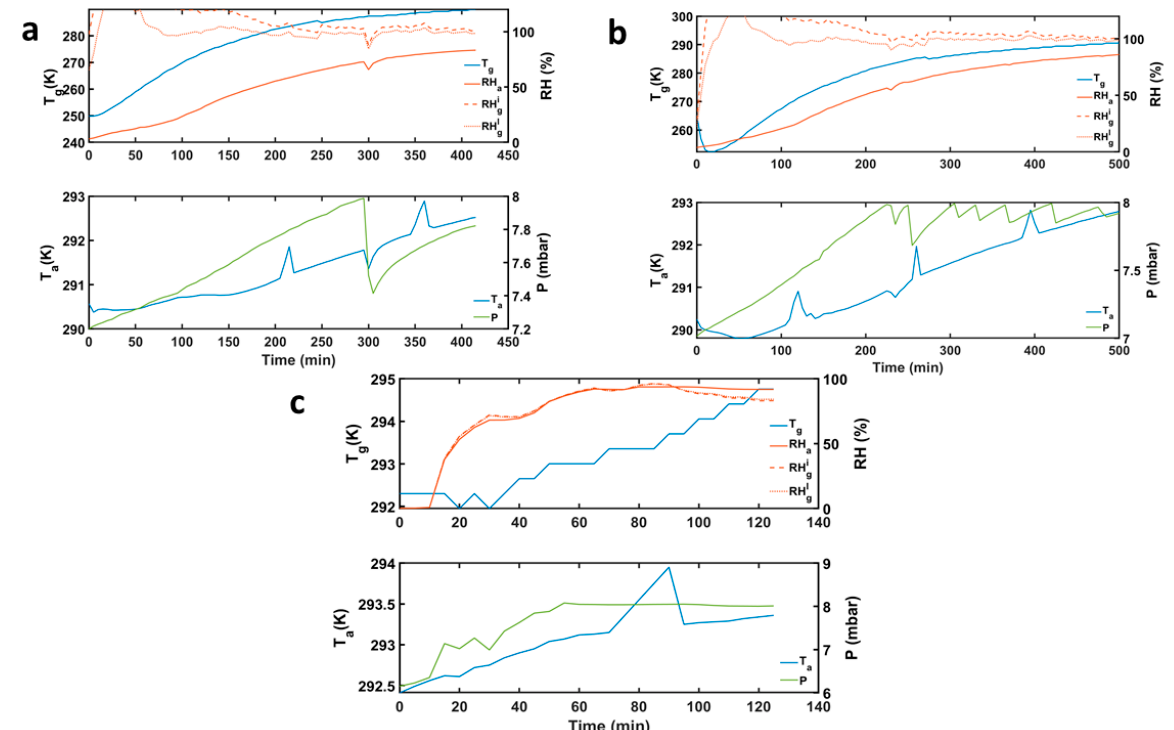
Figure 3. Evolution of the environmental variables inside the experimental chamber. The ground temperature (T g ) and air temperature (T a ), relative humidity of the air (RH a ) and total pressure (P) are measured, whereas the relative humidity with respect to ice and liquid (RH gi , RH gl ) are derived using Formulae (1)–(5). ( a ) Experiment 1: The water was injected; the table was cooled down to 250 K, and the pressure was controlled at Martian surface values. Then the temperature was raised slowly up to ambient conditions. RH a and RH g were significantly different due to the thermal gradient between the air and the ground. At the ground (table), the conditions are such that ice (frost) can be formed. ( b ) Experiment 2: Same conditions as in Experiment 1, with different products. ( c ) Experiment 3: Ambient